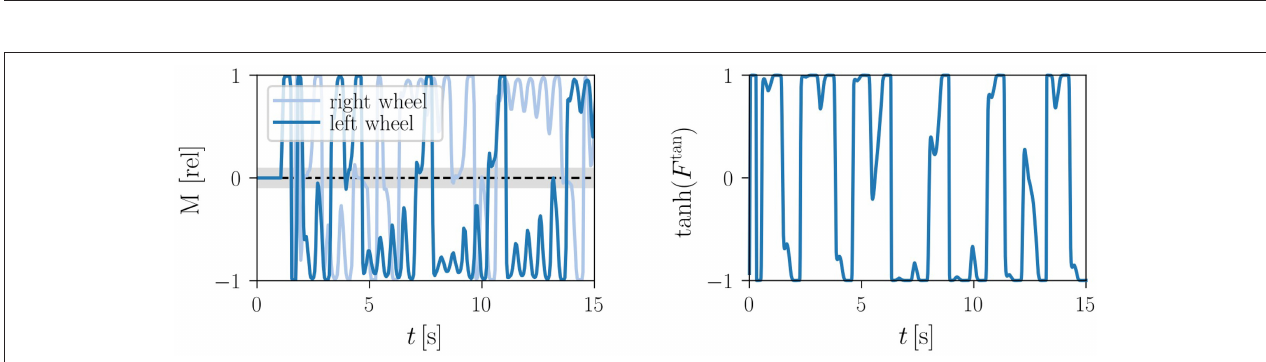
FIGURE 2 | Motion primitives corresponding to non-moving and to forward and backward limit-cycle locomotion. Note that the motor stalls for | M | < M thr ≈ 0.1 (gray area), viz when the torque M is unable to overcome the internal friction. Left : The measured output torque M for a = 4 and τ = 250ms as a function of the spring constant k . The measurements are performed after the robot settles in the forward (blue) or in the backward (green) attractor. For small k the robot stops moving and the tangential force vanishes. Right : An enlargement of the region k ∈ [0,2] showing the measurements (blue/green dots) and the corresponding stable limit cycle (blue/green lines). A saddle-node bifurcation of limit-cycles (SNC) is likely to occur when the torque is counteracted by the internal friction. The resulting unstable limit cycles (dashed blue/green lines) are shown.